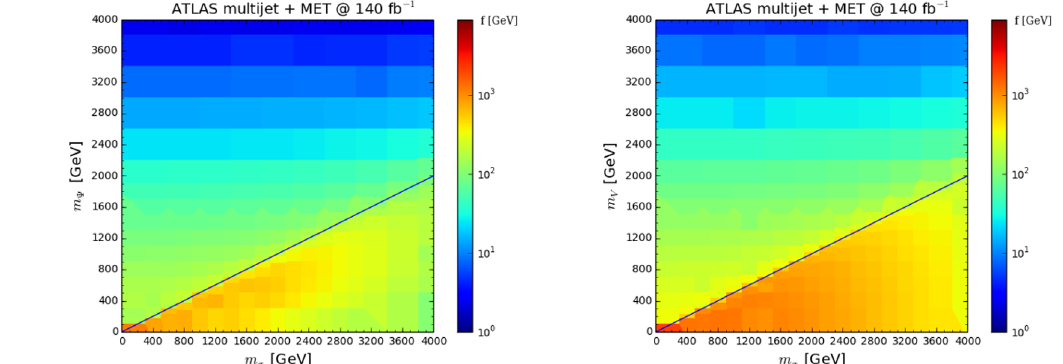
Figure 4 . Constraints on dilaton-induced dark matter for fermionic dark matter (left) and vector dark matter (right), presented in the ( m (cid:27) ; m V ) plane. For each mass con(cid:12)guration, we evaluate the maximum value of the cut-o(cid:11) scale that can be probed by using 140 fb (cid:0) 1 of LHC data and the ATLAS analysis of ref.